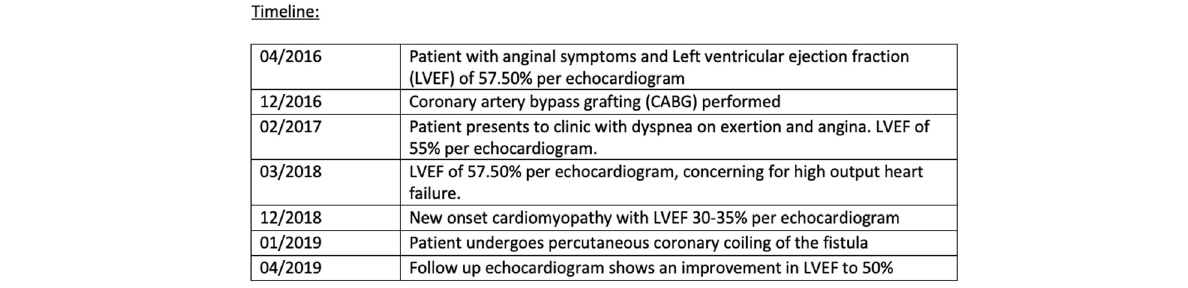
Table 1 Timeline of patient ’ s clinical and diagnostic